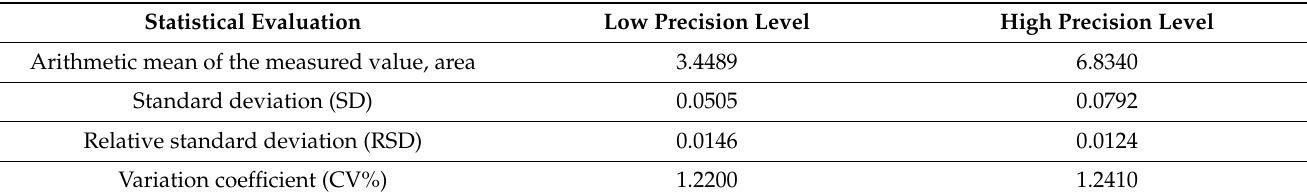
Figure 2. HPLC chromatogram of RAM–excipient model mixture solution. Table 1. Precision of the stability-indicating HPLC method for RAM analysis: low and high levels.